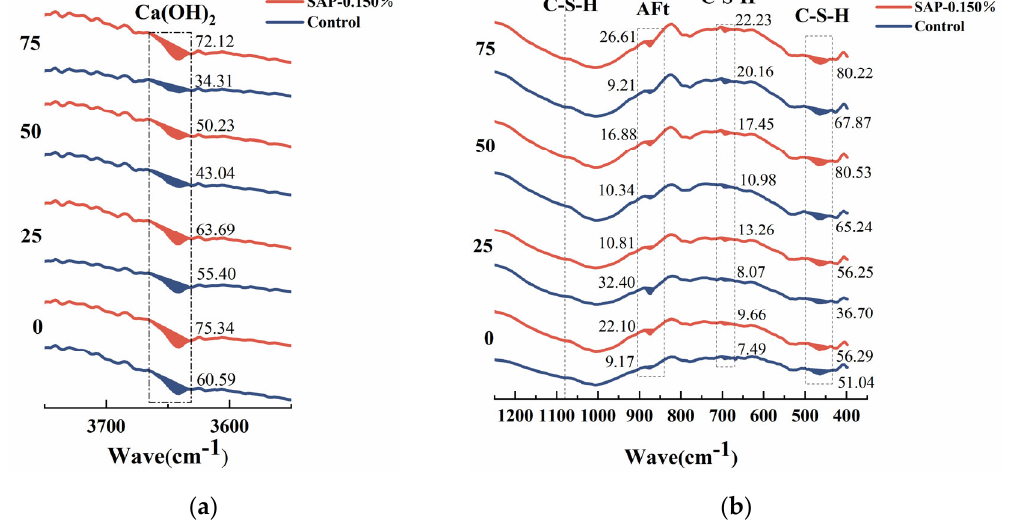
Figure 13. FTIR spectrum of SAP ‐ 0.150% and the control group with different times of salt freeze–thaw cycles: ( a ) the peak area of Ca(OH) 2; ( b ) the peak area of C ‐ S ‐ H and AFt.